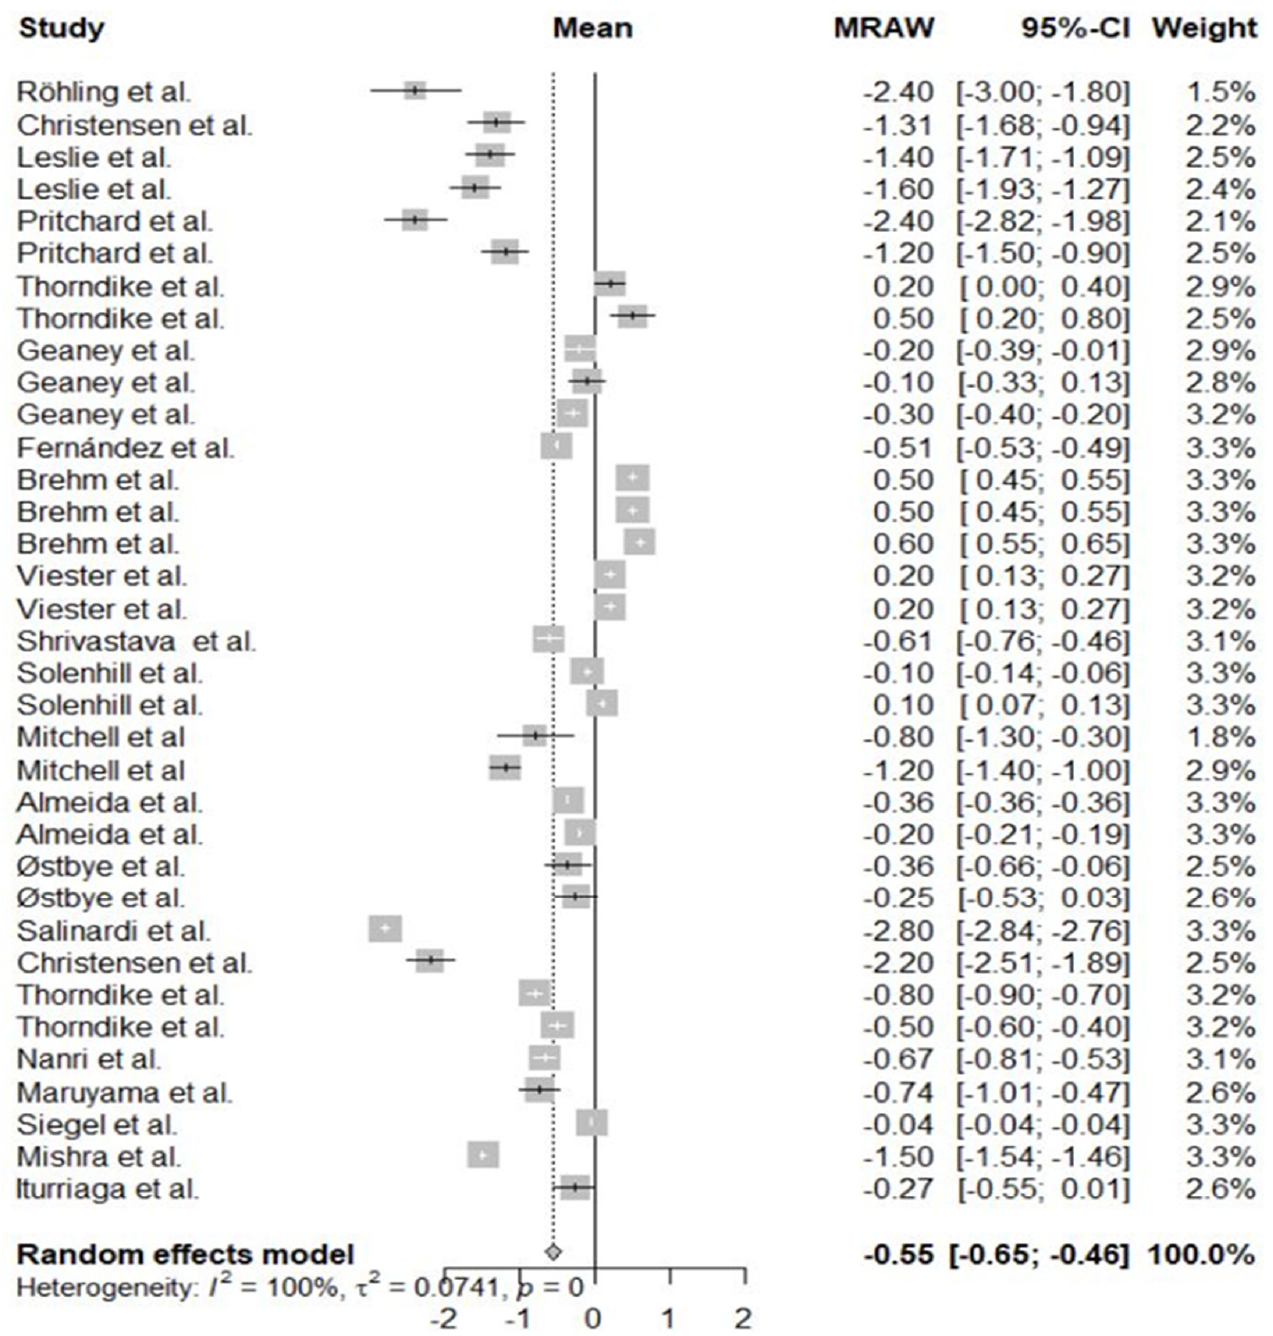
Figure 2. Forest plot for Body Mass Index.